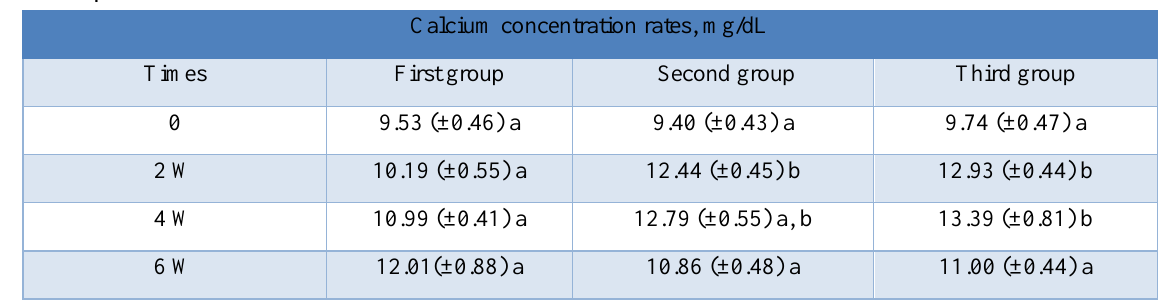
Table, 1: Show calcium concentration rates with its statistical analysis in the three main groups of experiment.